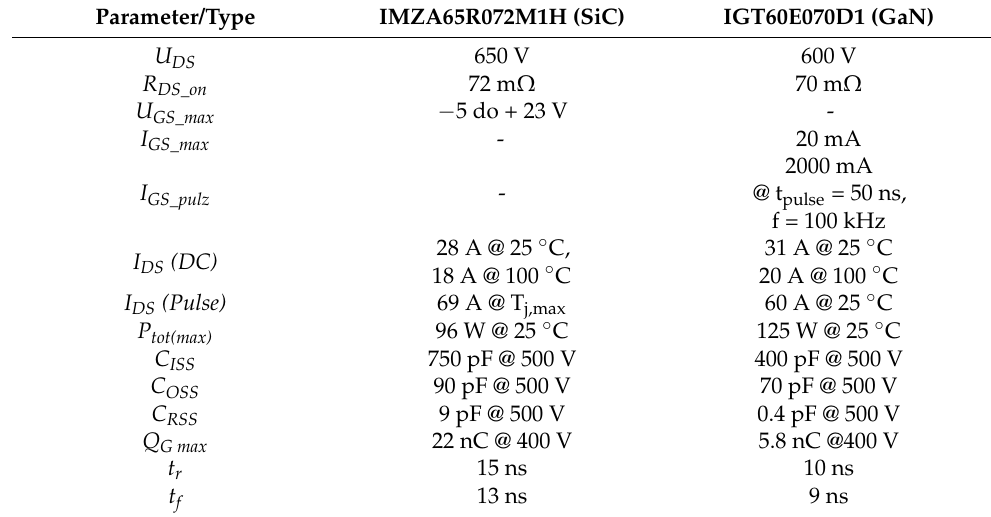
Table 5. Basic parameters of GaN and SiC selected power transistors for power loss calculation.